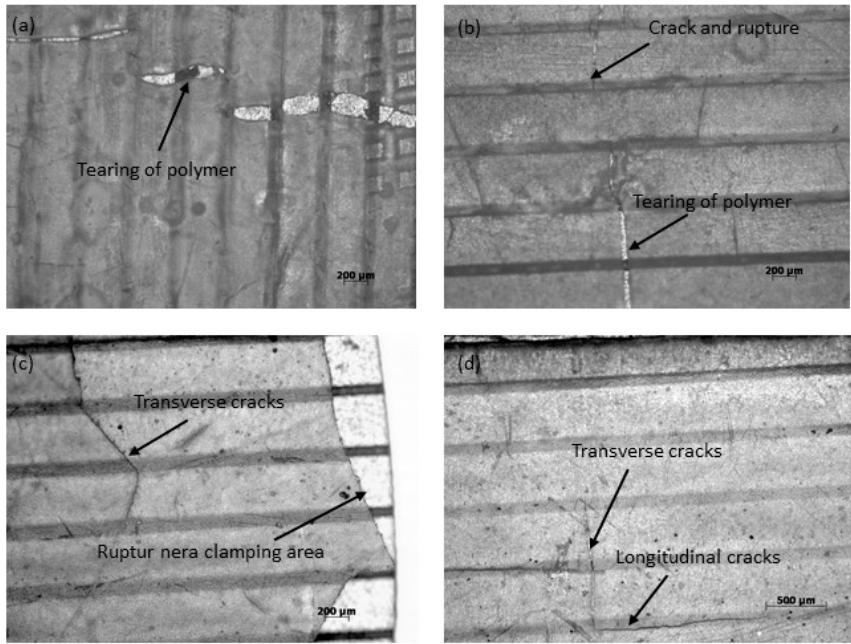
Figure 12. Optical microscopy surface images of the PMMA composite after the tensile test.